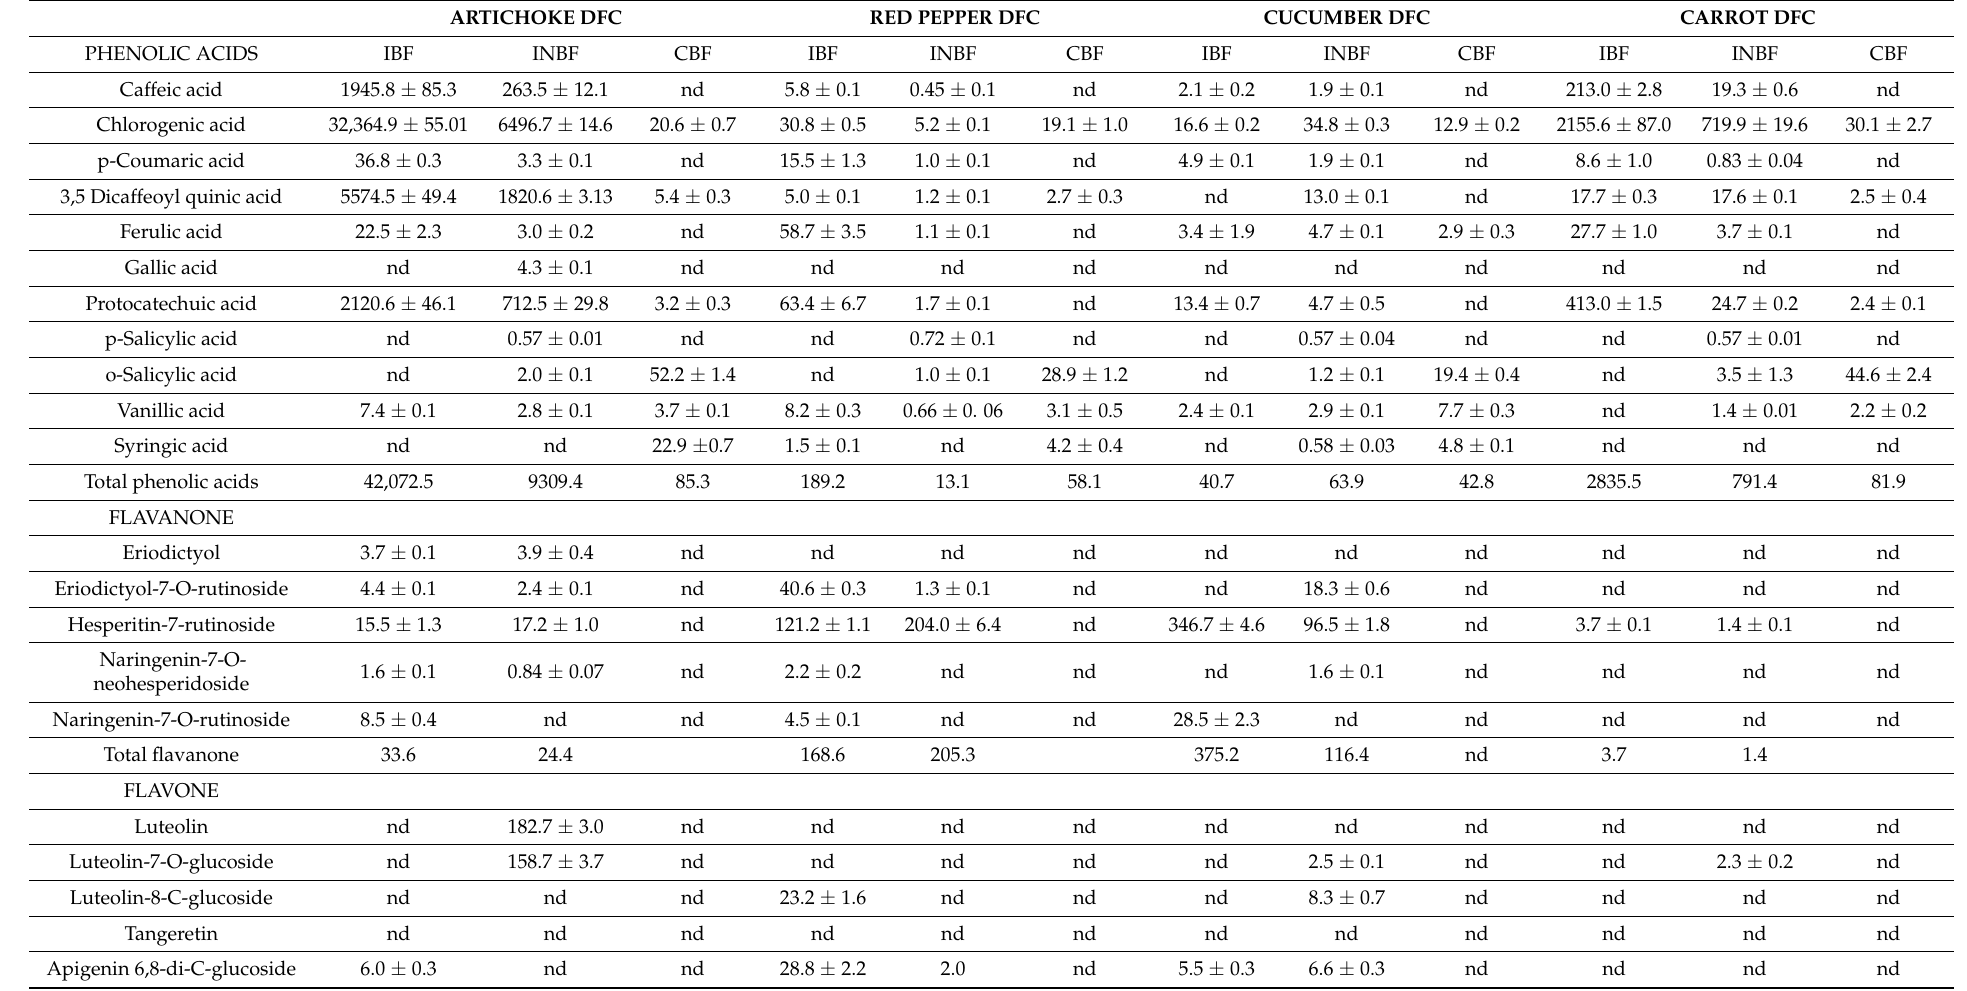
Table 4. Effect of gastrointestinal and colonic digestion on phenolic profile (mg/kg) of vegetable dietary fibre concentrate (DFC). ARTICHOKE